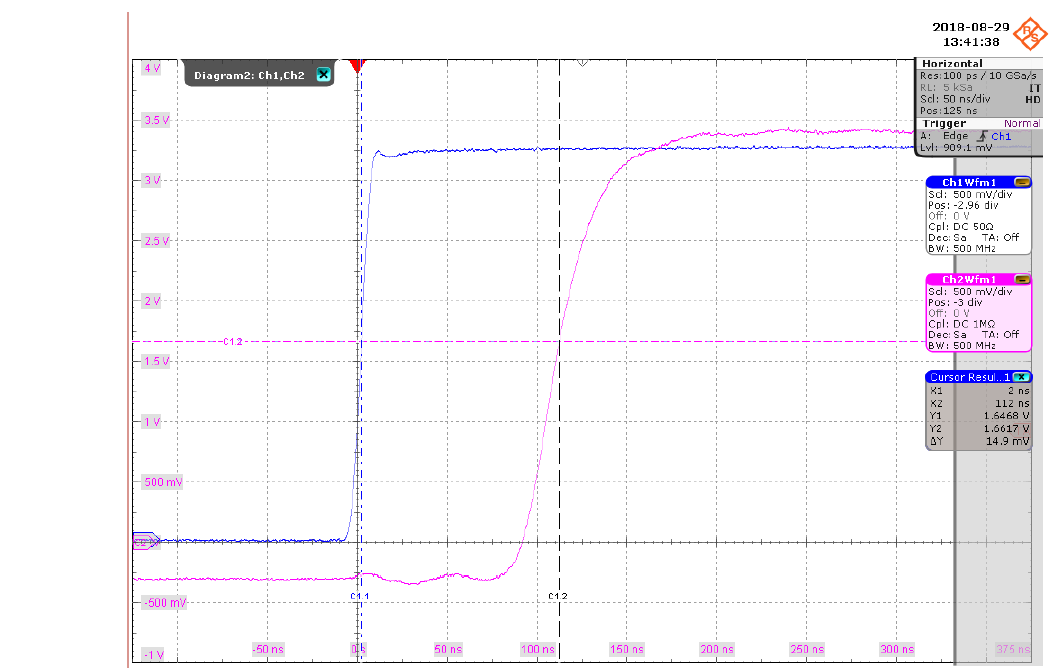
Figure 6. Comparison of timing behaviour for PWM transmission via dual-mode radio (purple line) and via cable (blue line).